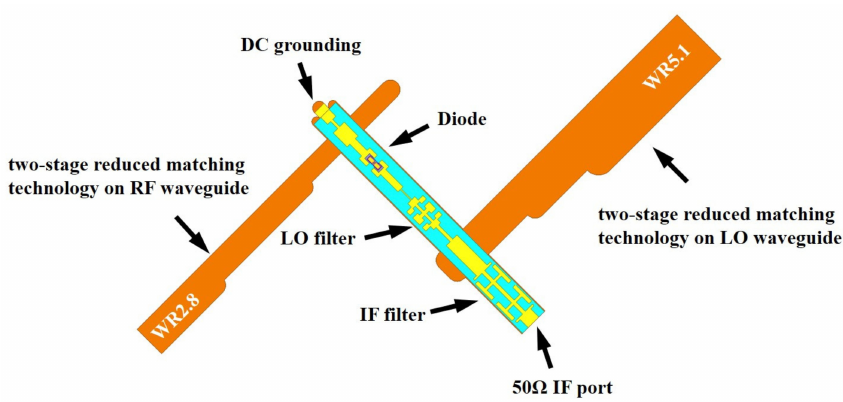
Figure 7. The overall structure of the proposed 0.34 THz sub-harmonic mixer.